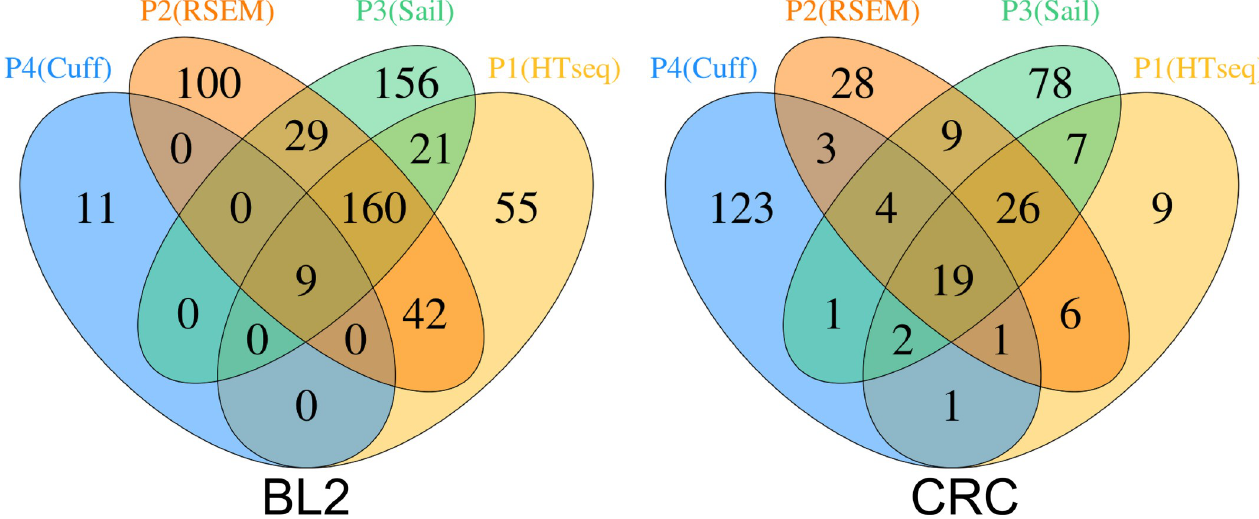
Fig 4. Significant overlapping genes for the different strategies after multiple test adjustment. Shown are two Venn diagrams, one for each dataset (BL2 Fig 4A and RC Fig 4B). The different pipelines used here are: TopHat2 and Cufflinks (T&C), STAR and HTSeq-Count (S&HT), Sailfish (Sa), STAR and RSEM (S&R). The microarray data is not included, because there were close to no significant genes after FDR adjustment.